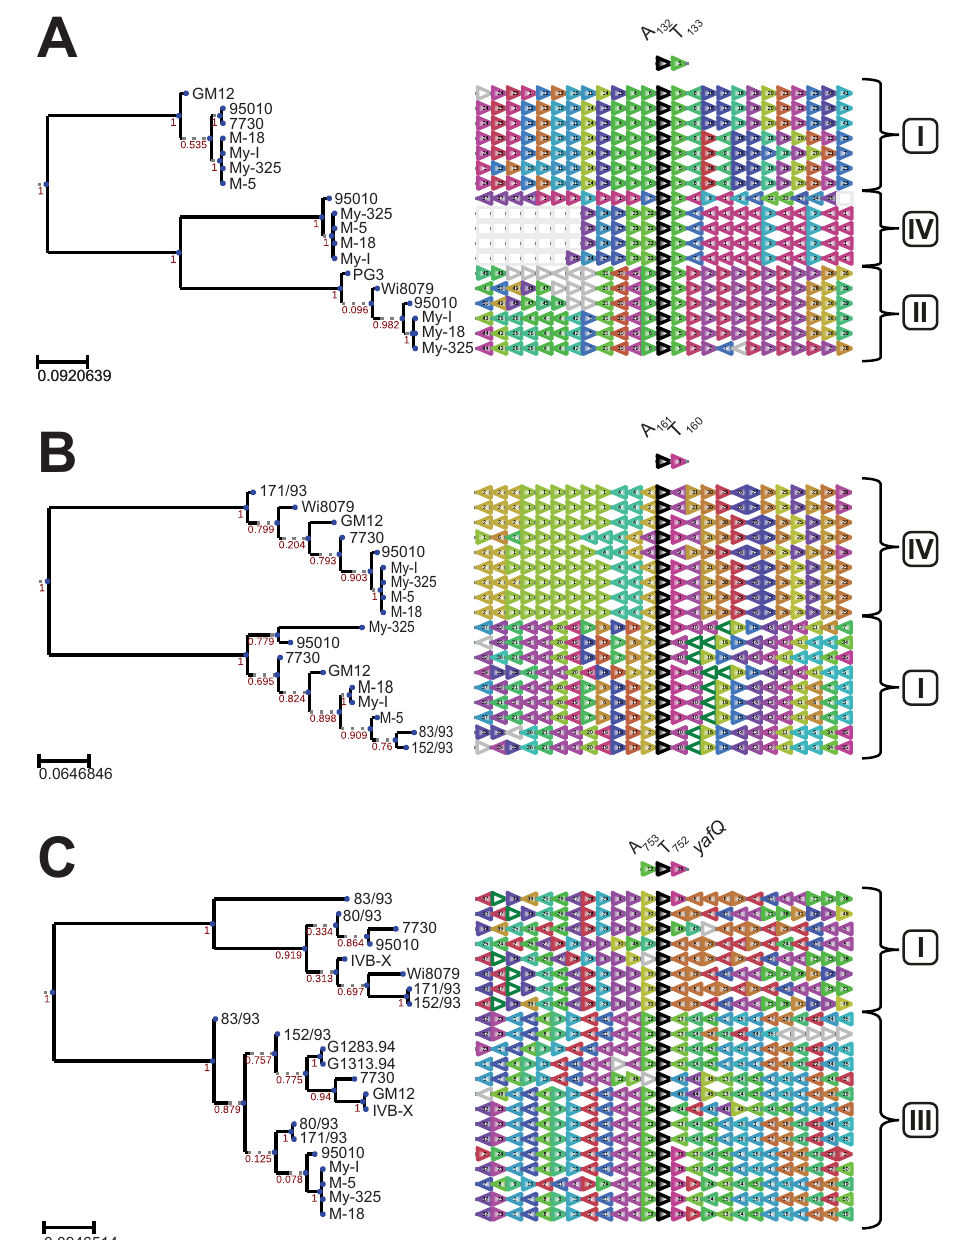
Fig 2. Genomic neighborhood and phylogenetic analysis of the candidate TA systems in Mycoplasma mycoides subsp . capri . The software FlaGs was used to infer the conservation of the genes flanking each candidate TA system, using each antitoxin as query (black arrowheads) and default parameters. Phylogenetic analyses of the different genomic neighborhoods are centered on each candidate antitoxin and are displayed for (A) the TA 132/3 system, (B) the TA 160/1 system, and (C) the TA 752/3 system. Genomic loci are colored and numbered according to their homology (see S3 File for the identity of clusters with flanking gene accession numbers). Nonconserved genes are not colored. Local support values are estimated with FastTree (default settings) included in FlaGs. Numbers (I-IV) refer to the four main TA regions previously identified on Mmc